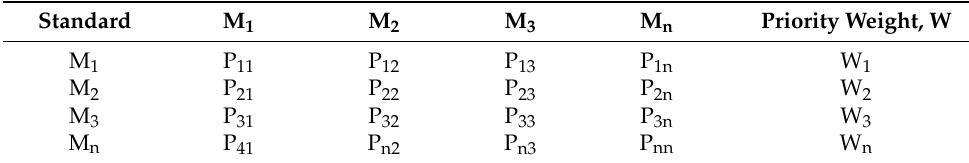
Table 1. Priority Weight